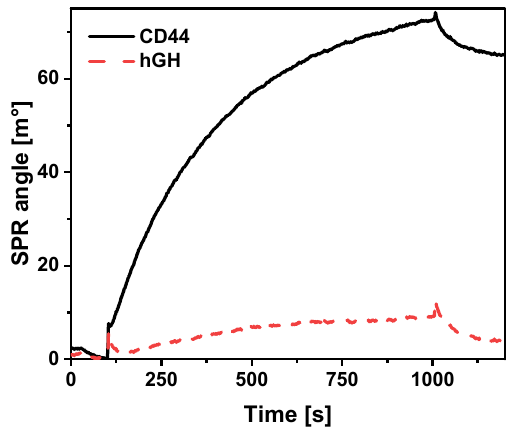
Figure 7. Interaction of QDs-anti-CD44 (QDs-NH 2 : anti-CD44 molar ratio 1:10) with CD44 and hGH immobilized on the surface of Au/MUA in different